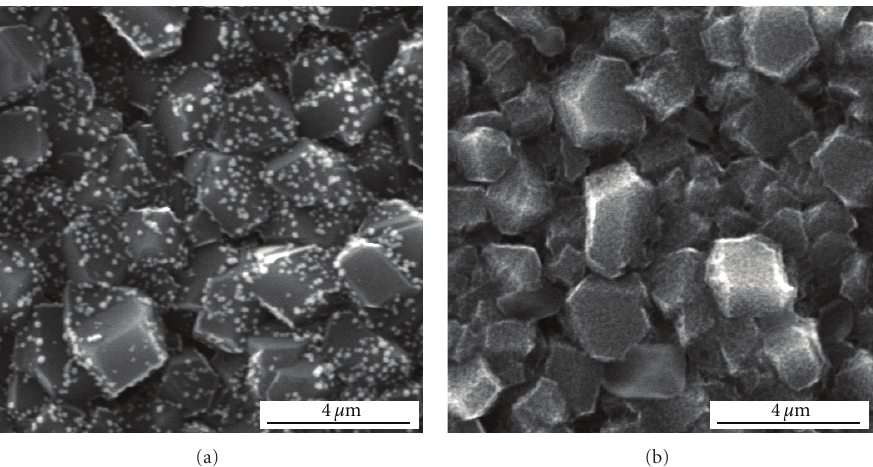
Figure 4: SEM images of (a) Cu and (b) Pd electrodeposited on BDD electrode. Both were deposited by 120 s, and − 0.3 V and 0.2 V were applied to deposit Cu and Pd,